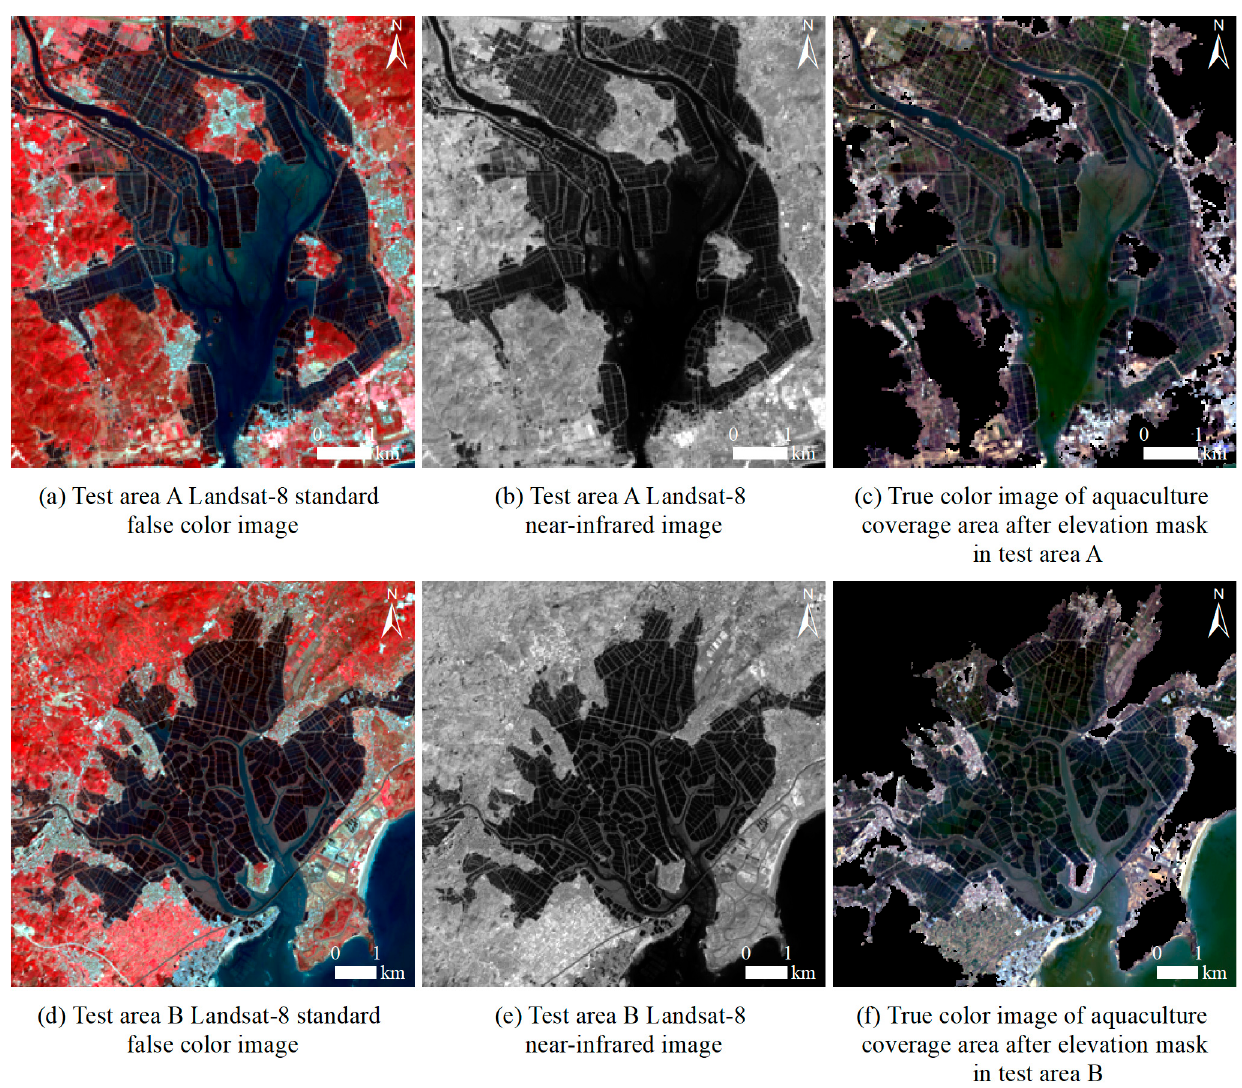
Figure 4. Delineation of potential aquaculture coverage areas in test area A